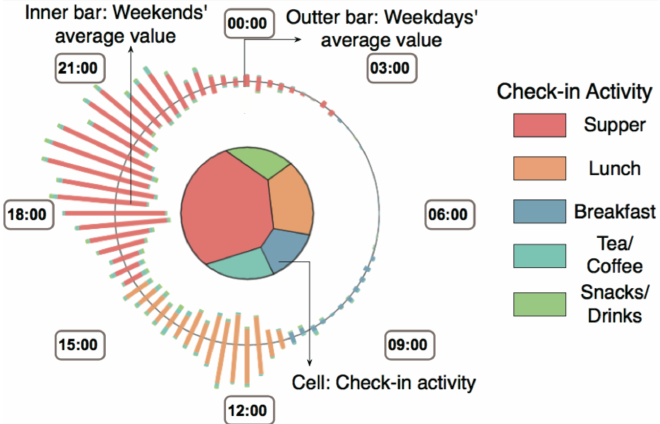
Figure 1. Region-based Fingerp rint of Social Check-in Behaviors. The Voronoi cells inside the icon encode check-in the activity type. The Voronoi cell size encodes the related number of check-in records of that activity. The color is used to categorize the activity type shown in the right part of the figure. The outer bar presents the average weekday value, while the inner bar shows the average weekend value. Each bar is formed by a set of slices of different lengths. One slice on the bar represents one type of activity and its length shows the related number of check-in records.